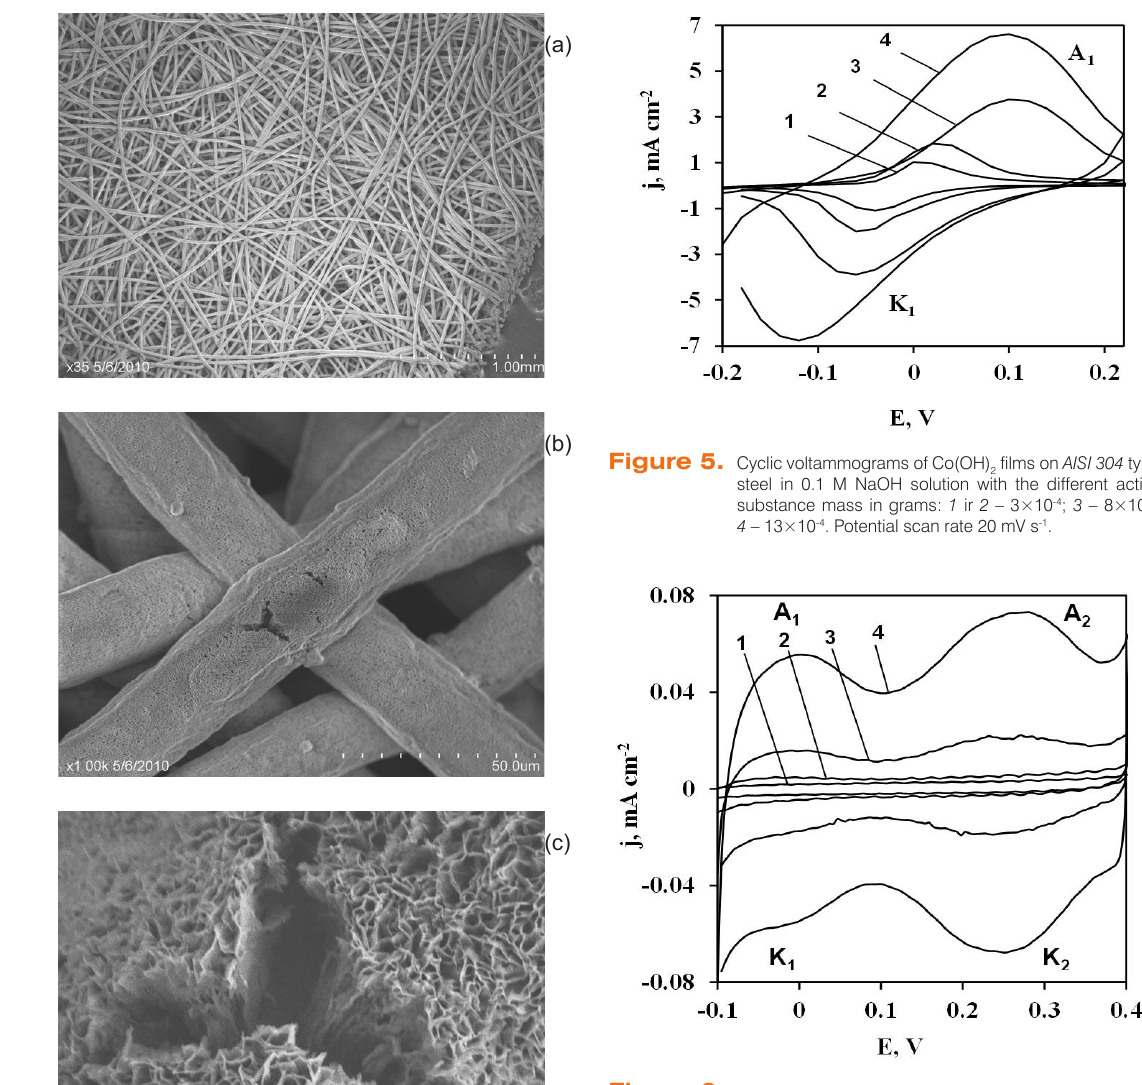
Figure 6. Cyclic voltammograms of Co steel in 0.1 M NaOH solution with the different